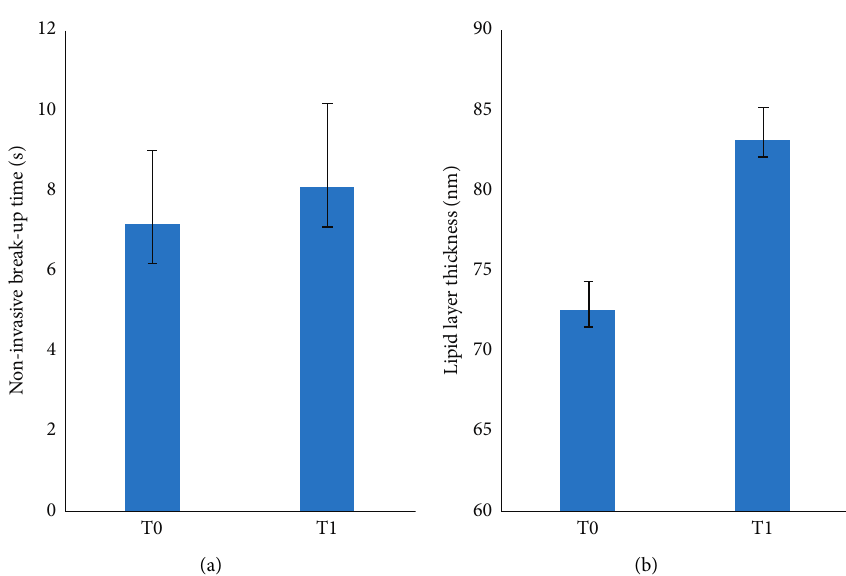
Figure 2: Histograms showing noninvasive break-up time (a) and lipid layer thickness (b) before and after the mask